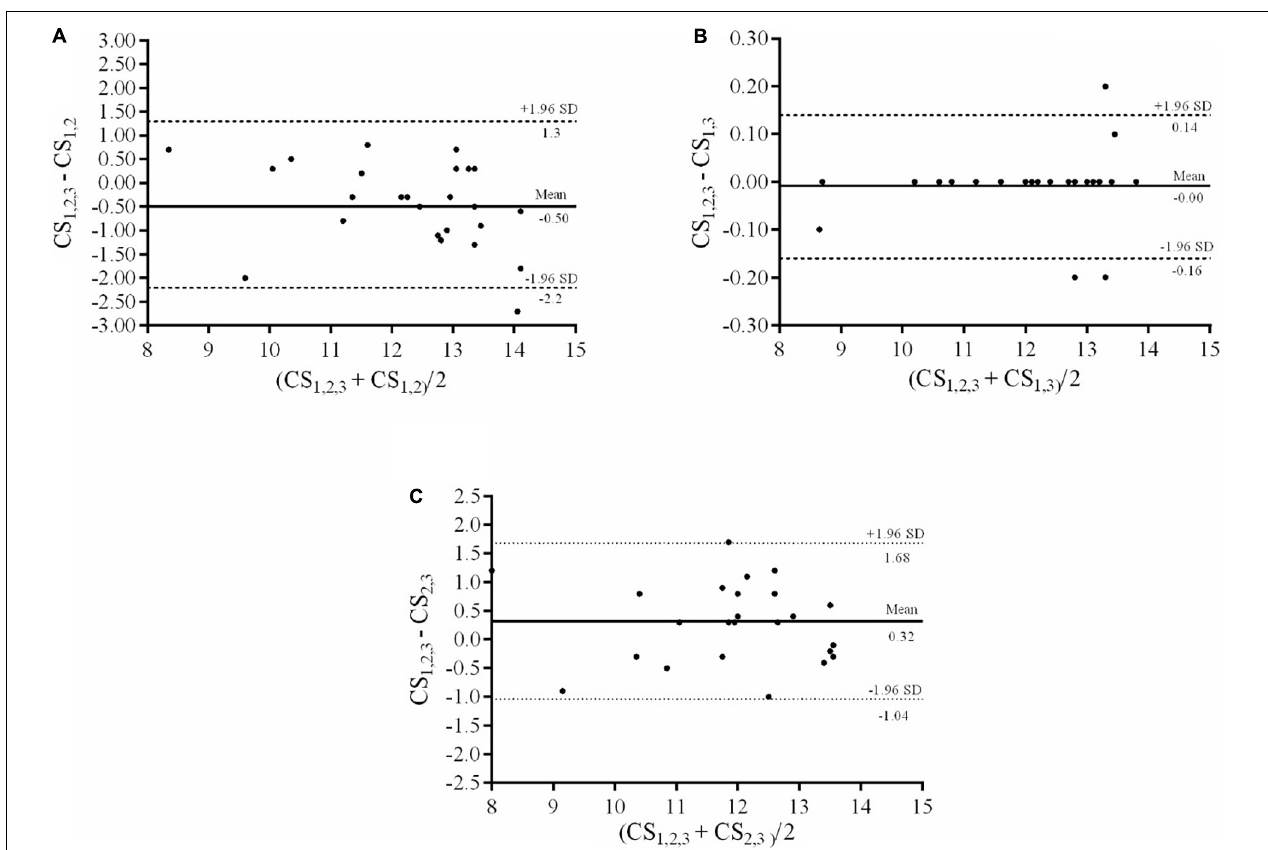
FIGURE 2 | Bland–Altman plots of the differences between CS 1 , 2 , 3 and CS 1 , 2 (A) , CS 1 , 3 (B) , and CS 2 , 3 (C) . Solid horizontal lines represent the mean bias, while dashed lines represent the lower and upper 95% limits of agreement. CS 1 , 2 , 3 : Critical speed at 2,600, 1,800 and 1,000 m; CS 1 , 2 : Critical speed at 2,600 and 1,800 m; CS 1 , 3 : Critical speed at 2,600 and 1,000 m; CS 2 , 3 : Critical speed at 1,800 and 1,000